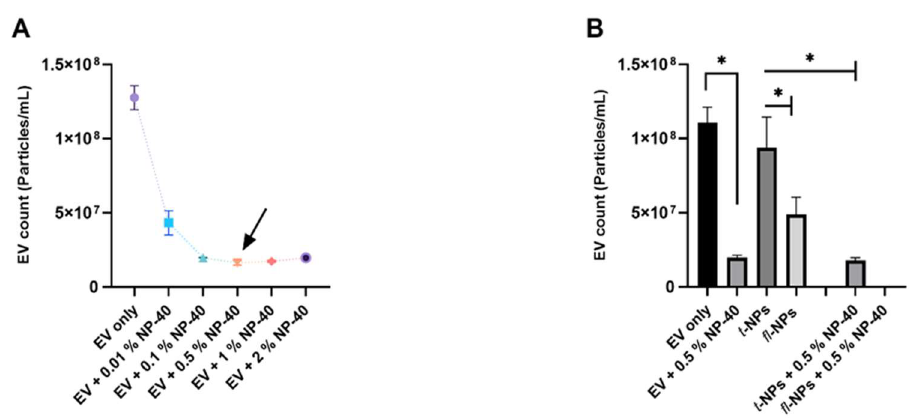
Figure 10. Concentration of fluorescent and total particles originating from JAr cells after NP-40 detergent treatment. EVs were labeled with 100 ng/mL of CMG and fl- NPs were measured at a minimum brightness threshold value of 25. ( A ) EVs were treated with different concentrations (0.01%, 0.1%, 0.5%, 1%, and 2%) of NP-40. EVs membrane was disrupted and saturation was reached at 0.5% concentration of NP-40. ( B ) EVs with or without CMG dye were treated with 0.5% of NP-40 and their respective particle concentration. The concentration of t-NPs of JAr EVs before 0.5% of NP-40 treatment was significantly different ( p ≤ 0.05) than the t-NPs of JAr EVs after NP-40 treatment. Thus, were marked with an asterisk (*) symbol. EV only controls, fl- , and t-NPs JAr EVs were diluted in 1x PBS and particle concentration was measured in fluorescent and scatter modes of NTA. (Mean ± SD, n = 9).